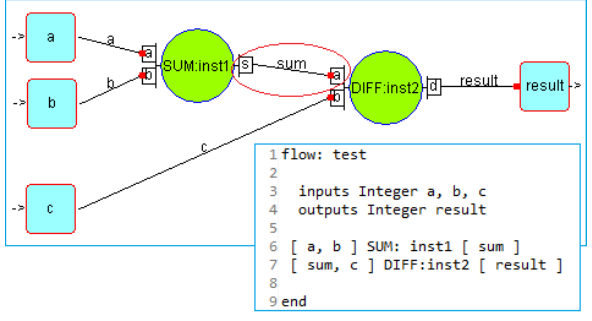
Figure 2. Connection